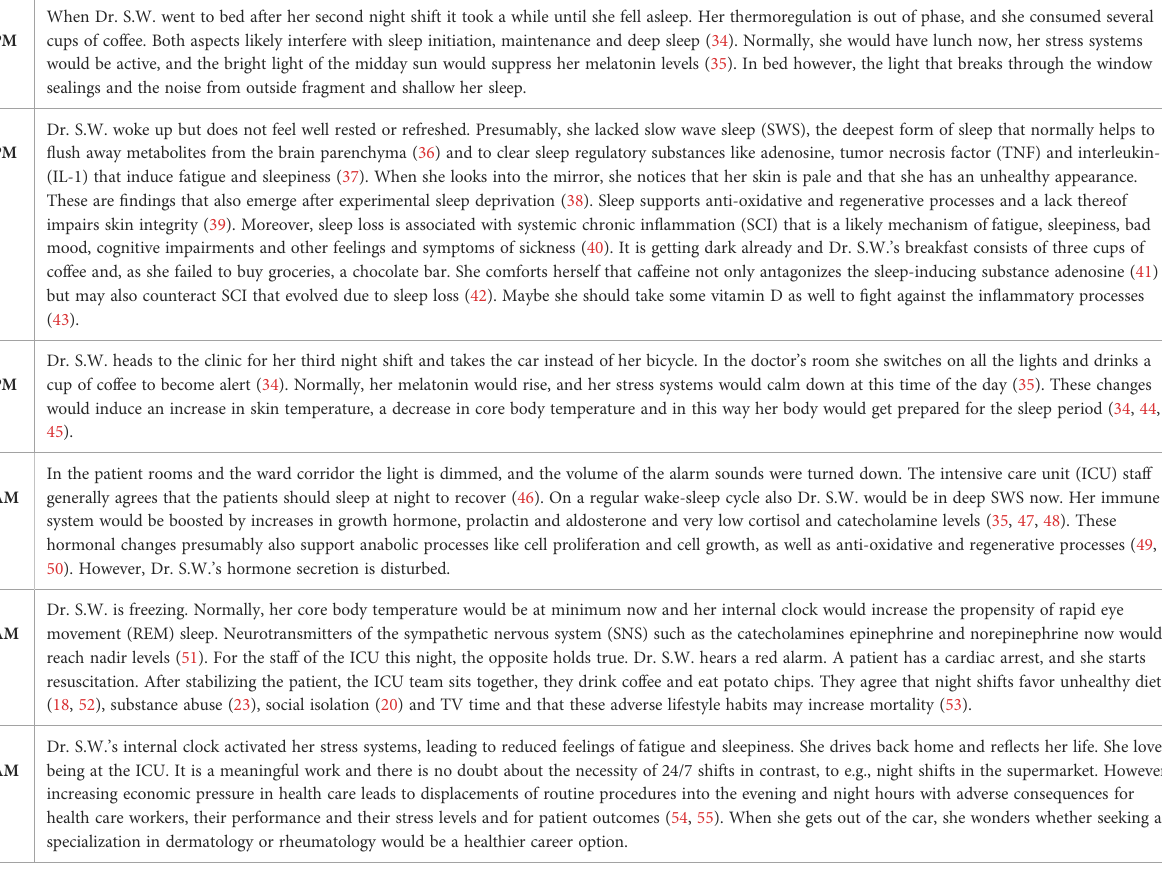
TABLE 1 24 hours in the life of Dr. S.W. on night